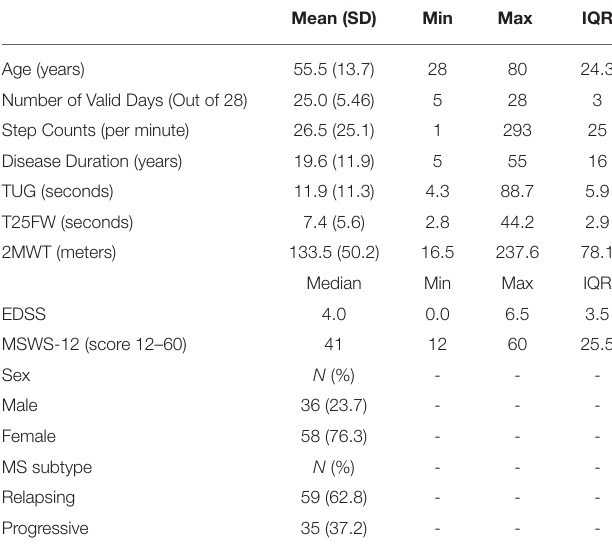
TABLE 1 | Demographic and clinical